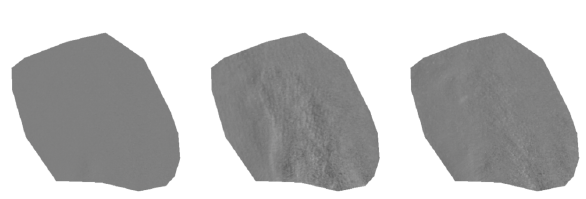
Fig. 8 Texture unwrap of the same samples as in Fig. 7.